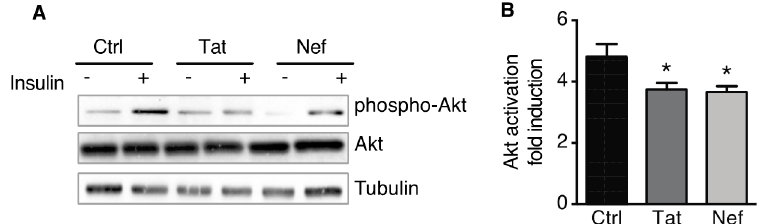
Figure 7. Nef- and Tat-induced senescence in ASCs was associated with insulin resistance in ASC-derived adipocytes. After 30 days of treatment with Tat or Nef, ASCs, isolated from different abdominal SCAT healthy donors, were differentiated into adipocytes for 14 days. The treatment was stopped during the differentiation. ( A ) On day 14 of differentiation, the cells were stimulated (or not) with 100 nmol/L insulin for 7 min. Representative immunoblots of phosphorylated-Akt, Akt, and tubulin (loading control) are shown ( n = 3). ( B ) The fold induction of Akt activation by insulin was quantified, and results are shown as the mean ± SEM ( n = 3). * P < 0.05, ** P < 0.01 vs. control cells.